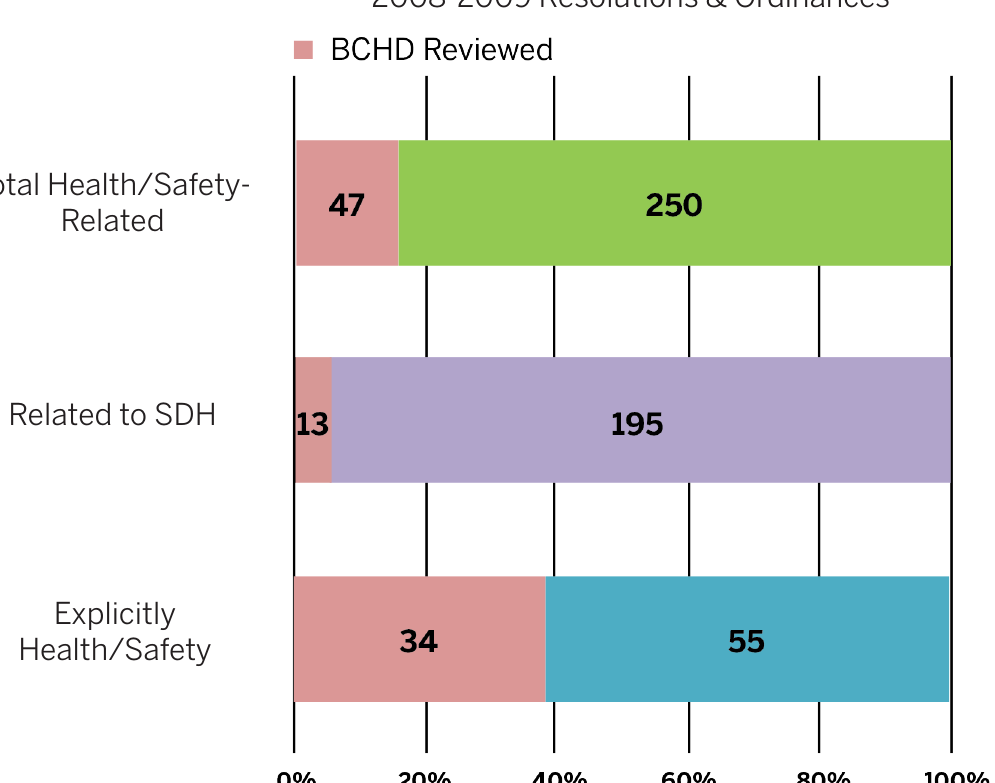
Figure 1: BCHD is Baltimore City Health Department. Note that a total of 17 policies were not on file in the database and were therefore not included in this review. Figure 2: Summary of 2008 & 2009 Polices Referred for Health Review